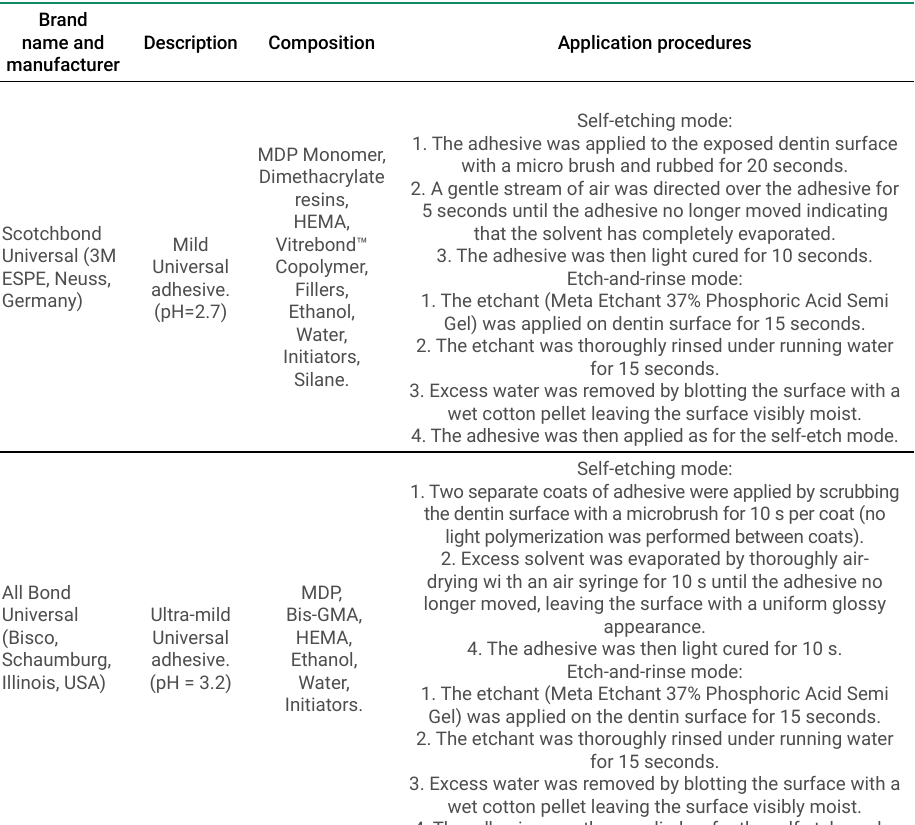
Table 1. Adhesive systems, their description, composition and application procedures according to the manufacturer’s